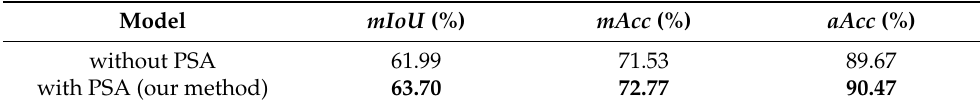
Table 7. Ablation study of the attention mechanism. Best results in each category are in bold .